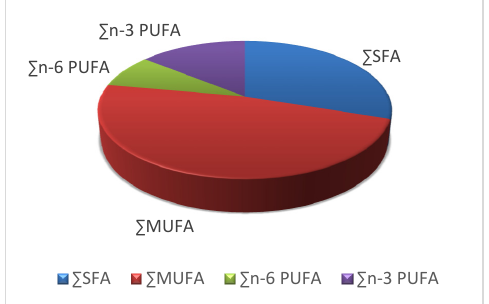
Figure 4. The percentage content of fatty acids (%) in muscles of the European eel ( Anguilla anguilla L.).